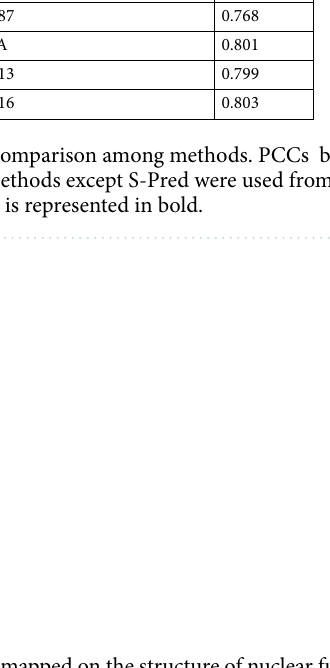
Figure 3. S-Pred ASA predictions mapped on the structure of nuclear fusion protein BIK1 (PDB ID: 6FC6). The residues are represented using a gradient color scale from cyan (buried) to maroon